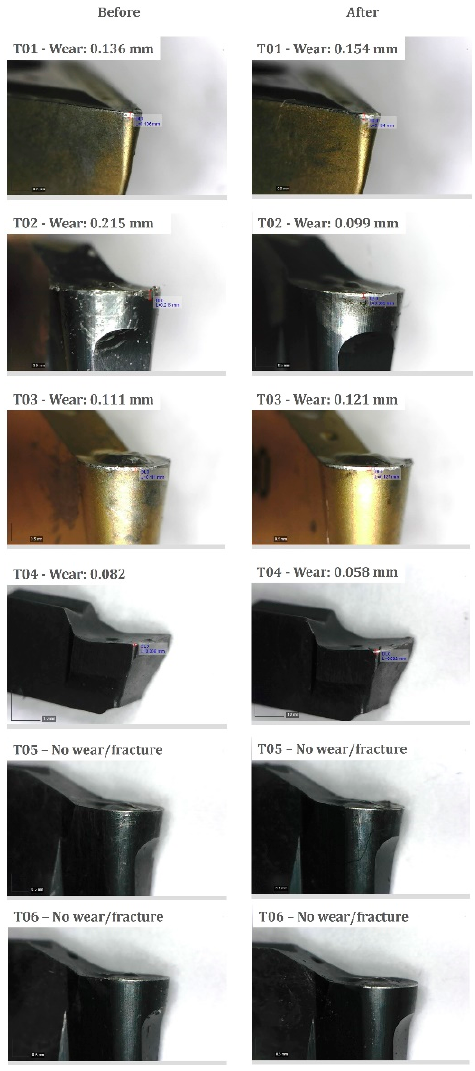
Figure 8. Cutting tool wear at finishing.